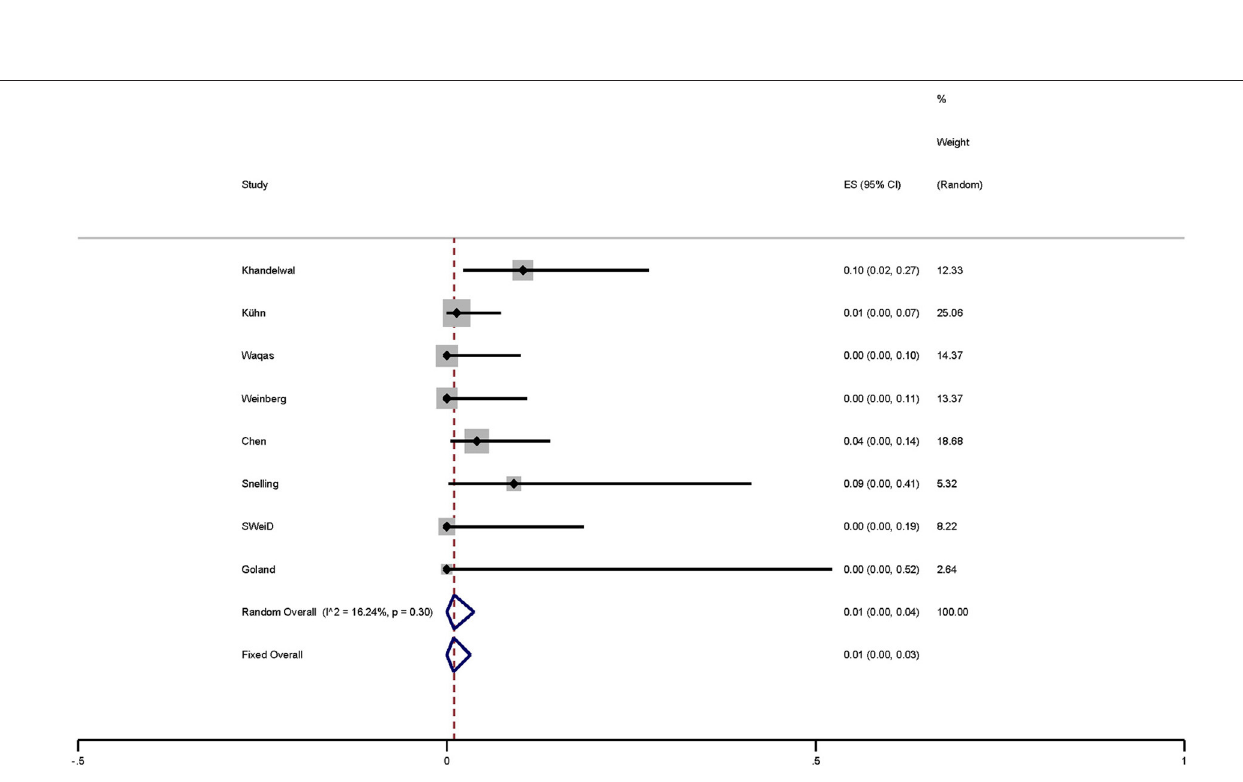
Frontiers in Neurology |